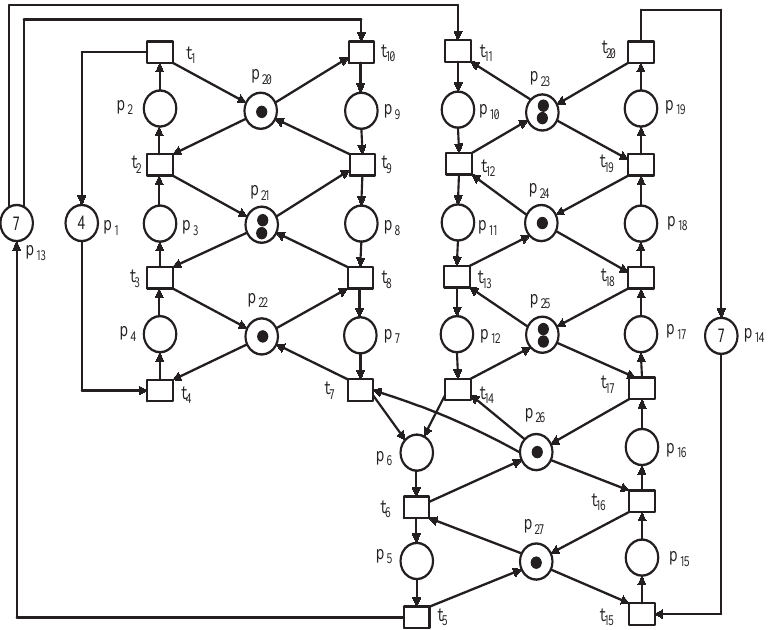
Figure 11. Petri net model for an